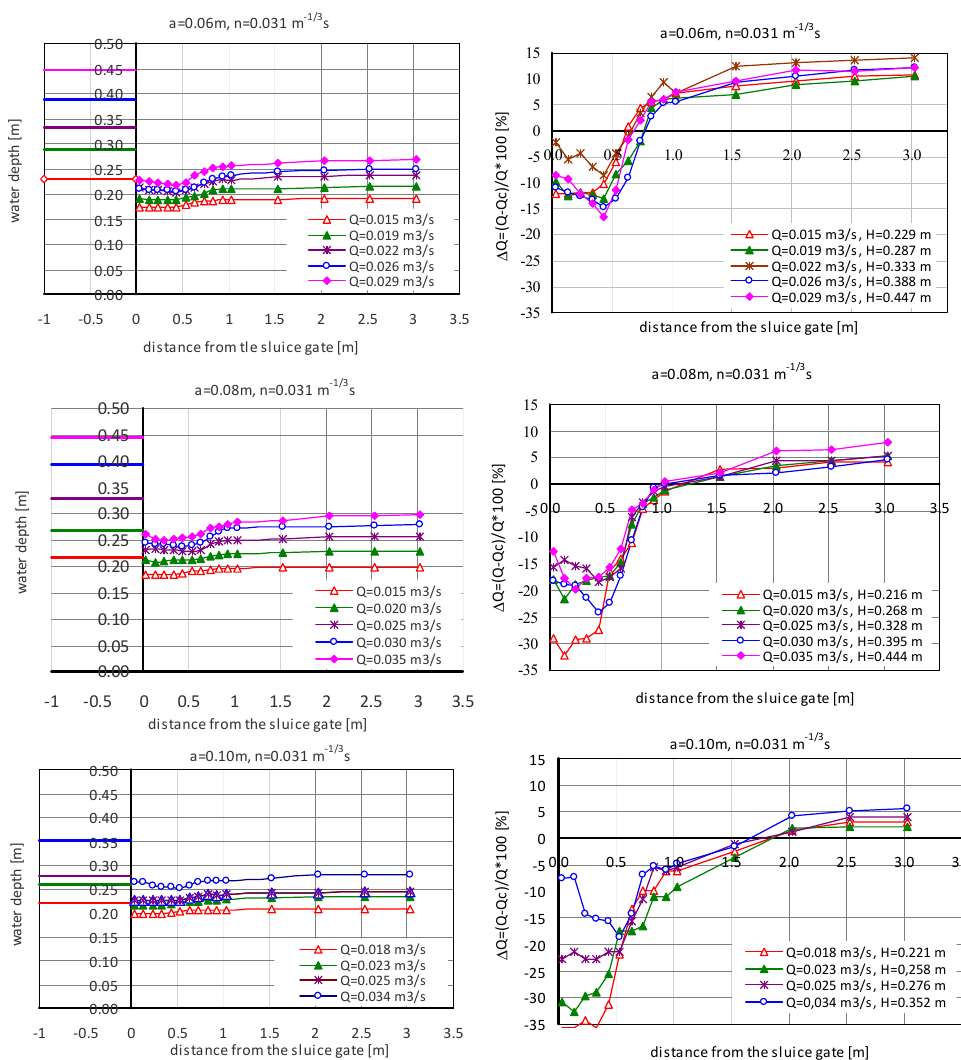
Figure 6. Measured water level profiles downstream of the gate in Case V1 experiments for the submerged sluice gate and constant roughness coefficients in the channel, with percentage deviation ∆ Q of the measured flow rate Q from the calculated Qc on the basis of the measured depths. The distance L d from the gate to the cross-section in which the measured downstream water depth h d ensures agreement between the calculated and observed flow rates is independent from the roughness coefficient in the downstream channel and increases with the height of the gate opening a. For the opening height a = 0.06 m, the depth h d should be measured in the cross-section located at a distance L d ≈ 10a downstream of the gate valve. Increasing the sluice gate opening to a height of a = 0.08 m means that the downstream water depths should be measured at a distance of about L d ≈ 15a. Increasing the gate opening to a = 0.10 m shifts the measuring cross-section to a distance of L d ≈ 18a (Figure 7).